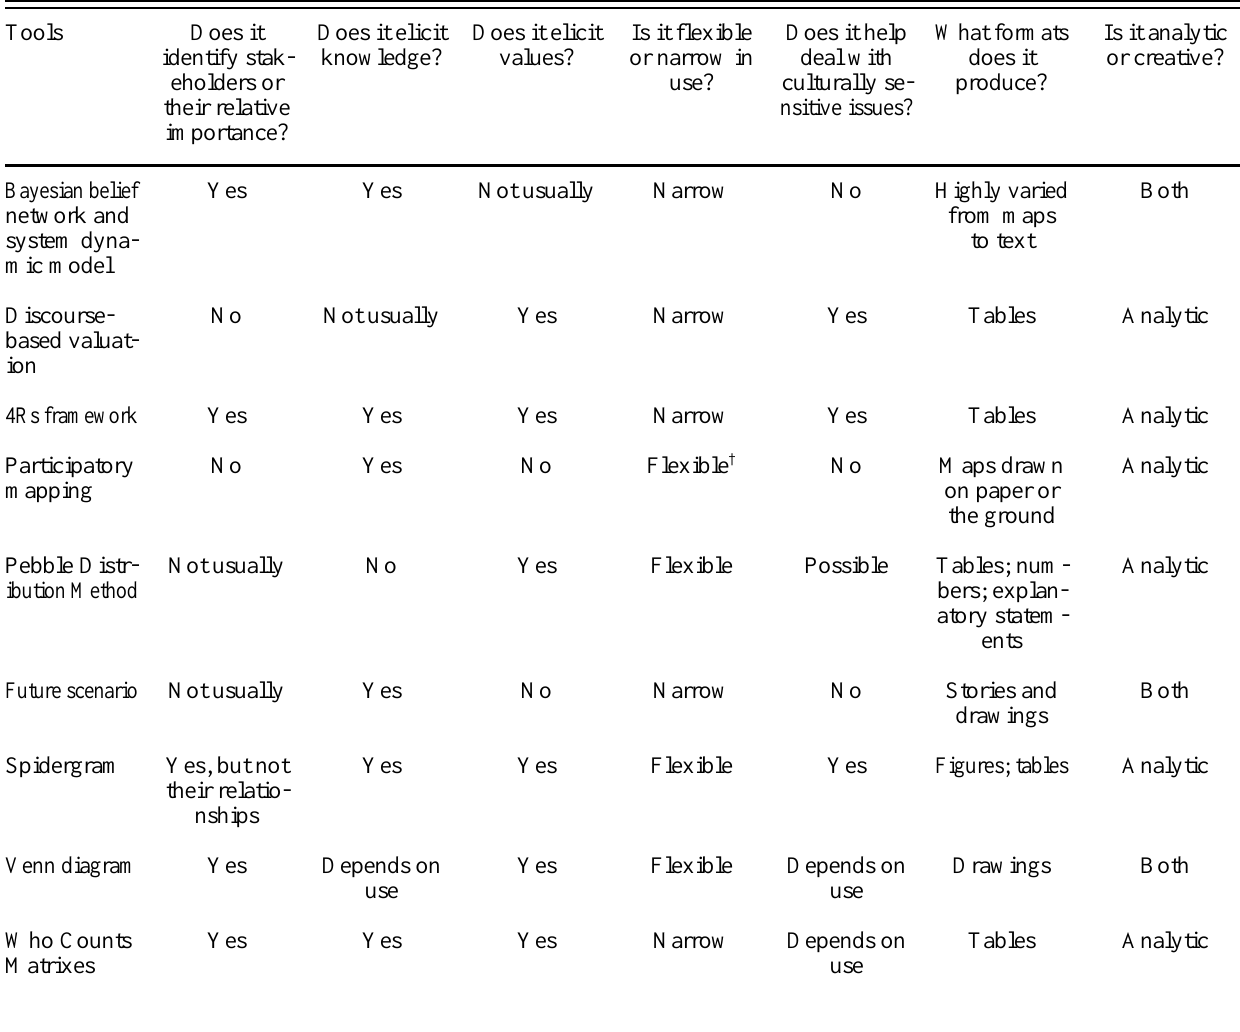
Table 2 . Evaluation criteria applied to each of the tools reviewed: use. Tools